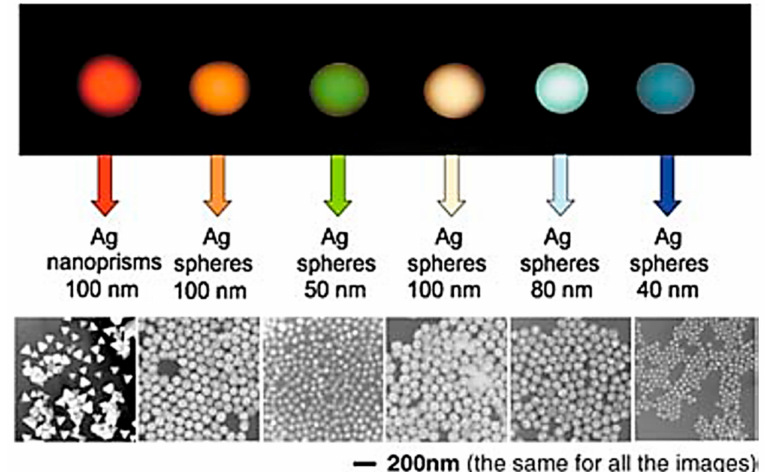
Figure 1. Nanoparticles behave differently depending on the size and shape of the material. This figure shows the difference between the Rayleigh light-scattering properties of silver nanoparticles (reproduced from [12] with permission, copyright Wiley,